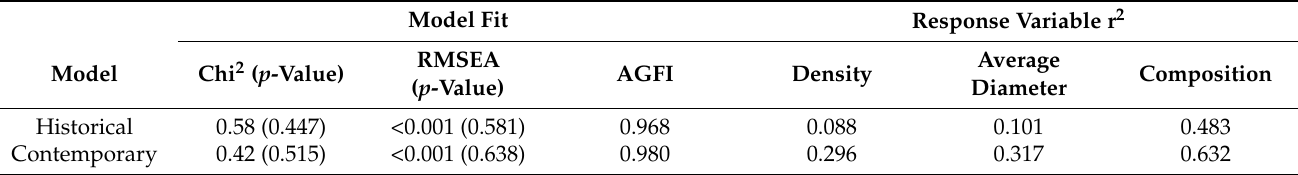
Table 1. Summary of structural equation model (SEM) performance. Measures of model fit (Chi 2 ) p -value, root mean square error of approximation (RMSEA), and an adjusted goodness-of-fit index (AGFI) are reported, as are measures of the predictive power of the models (r 2 for average diameter, density, and composition). Model fit statistics are calculated over one degree of freedom for both historical and contemporary models.